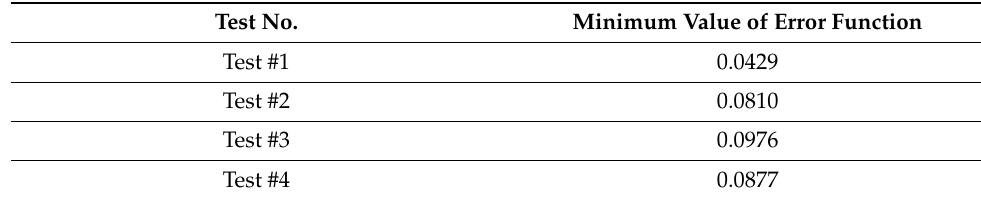
Figure 15. Variation in the error function at each iteration of the Genetic Algorithm in test #4.